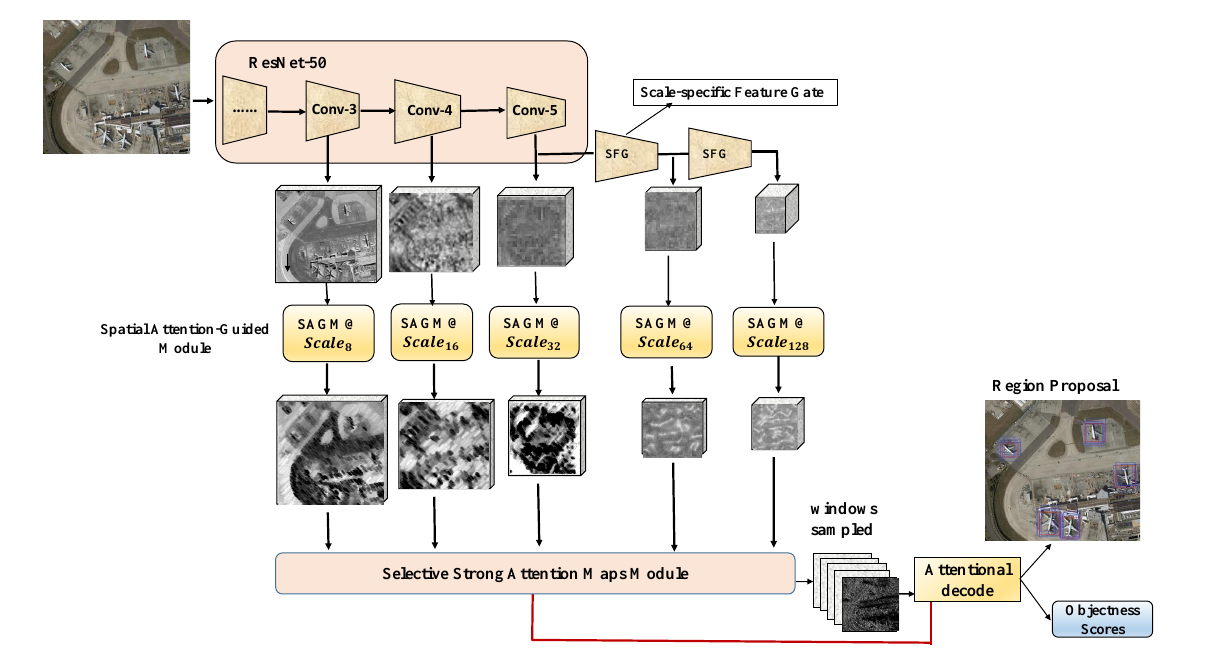
Figure 1. Framework of the proposed MSA-RPN.